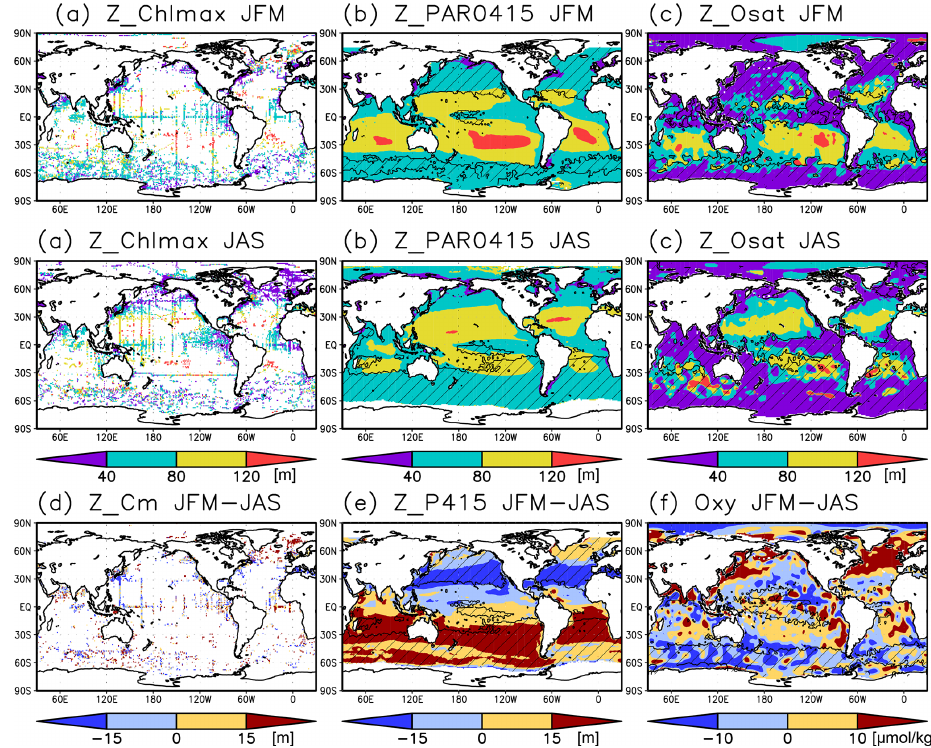
Figure 7. (a–c) Depths of the chlorophyll a (Chl a ) maximum, photosynthetically active layer ( > 0 . 415molm − 2 d − 1 of photosynthetically available radiation), and oxygen-oversaturated layer in January–March (JFM) (top row) and July–September (JAS) (middle row), respec- tively. (d–f) Differences between the Chl a maximum depth, photosynthetically active layer depth, and dissolved oxygen concentrations